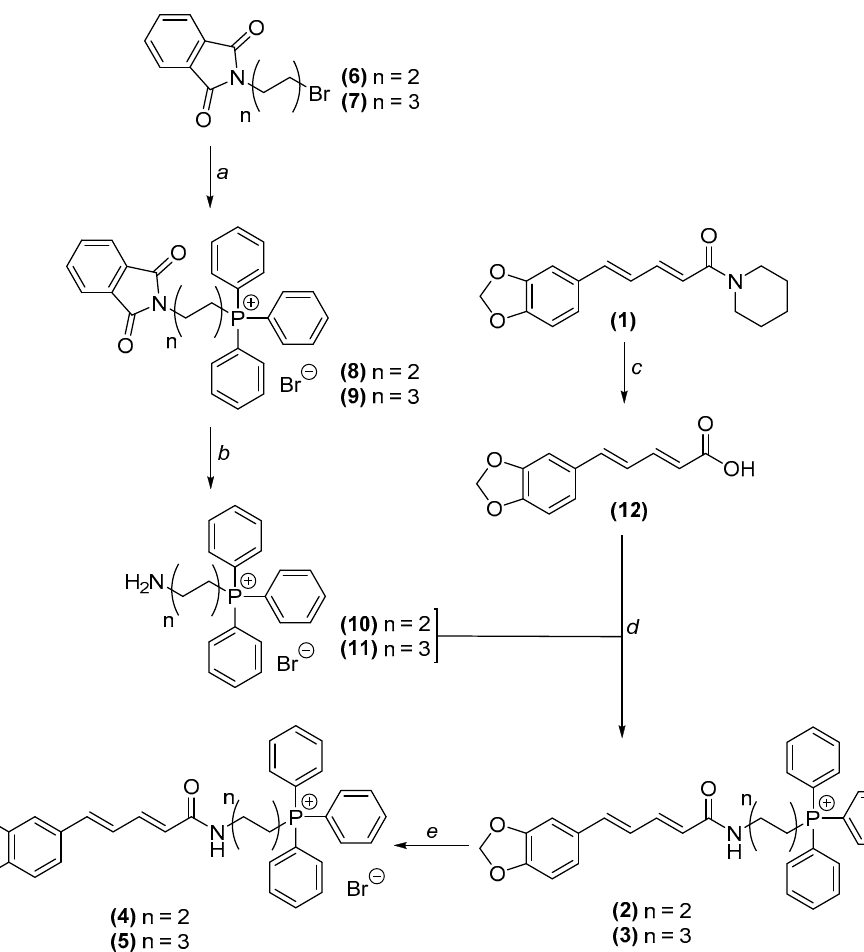
Table 2. Evaluation of ChE ( ee AChE, eq BChE, h AChE, h BChE) inhibitory activity of piperine (compound 1), compounds 2–5, AntiOXCIN2 and AntiOXCIN3 and reference